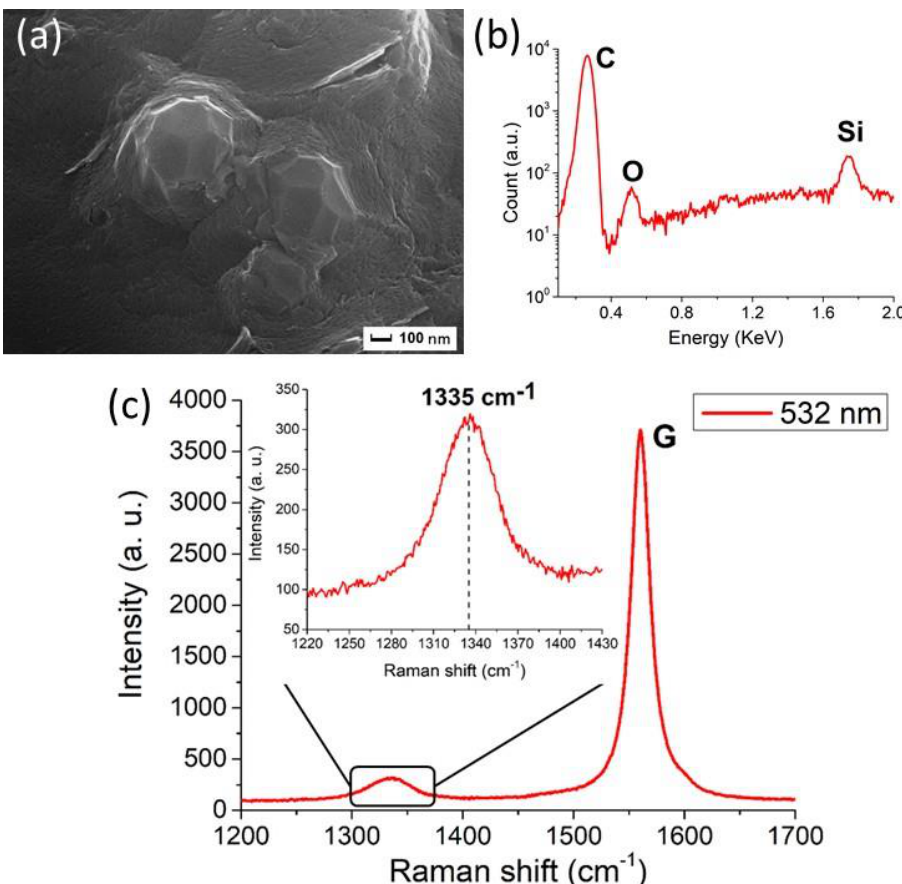
Figure 5. Characterization of the NDs from graphite ablation in water. ( a ) Typical Scanning Electron Microscopy (SEM) image, after removal of the non-diamond phase of carbon, showing clustered nanoparticles of about 100 nm size. ( b ) Energy-dispersive X-ray Spectroscopy (EDXS) spectrum of the nanoparticles. The carbon peak is detected at 0.27 keV. Moreover, the peaks of silicon at 1.74 keV and of oxygen at 0.52 keV are observed. They come from the substrate on which the particles are deposited and from the oxidized surface layers of the ablated powders, respectively. ( c ) Raman spectrum (obtained under 532 nm excitation wavelength) of purified particles. The main peak at 1580 cm − 1 is the graphite G peak, while the peak at 1335 cm − 1 (shown in detail in the inset) is attributed to compressively-strained NDs. Reproduced with permission from [40], Springer, 2018.